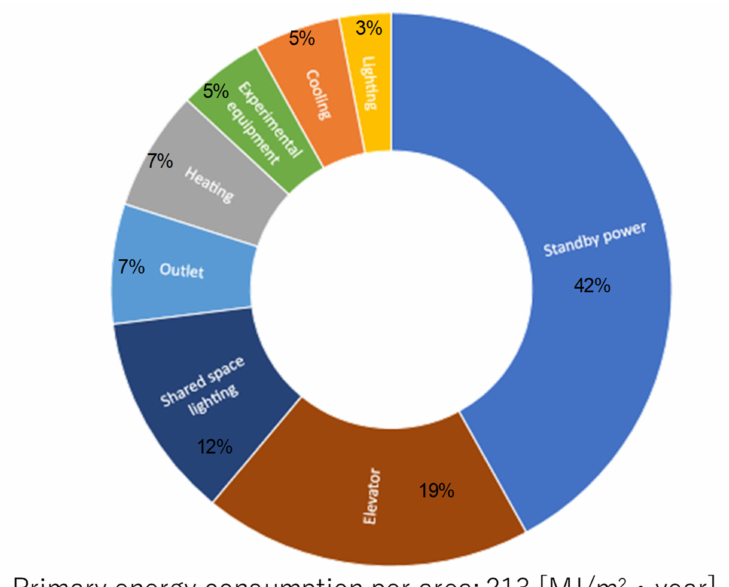
Figure 7. The ratio of the energy consumption for each item to the primary energy consumption per annual area